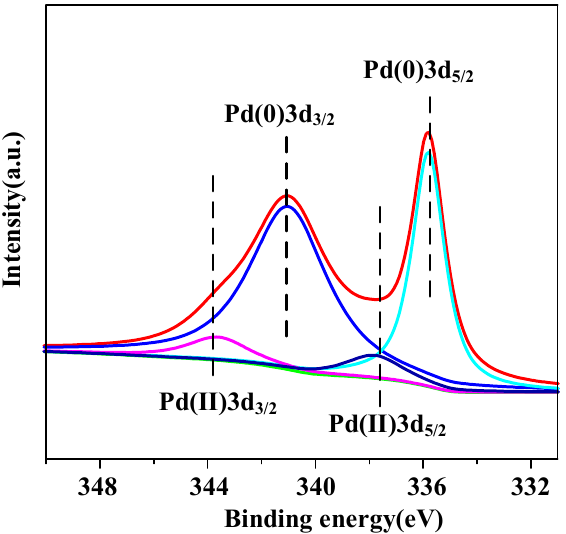
Figure 1. XRD patterns of ( a ) CNTs; Pd/CNTs with different Pd composition ( b ) 0.9 wt%, ( c ) 2.1 wt%, ( d ) 3.0 wt% and ( e ) 4.1 wt%.